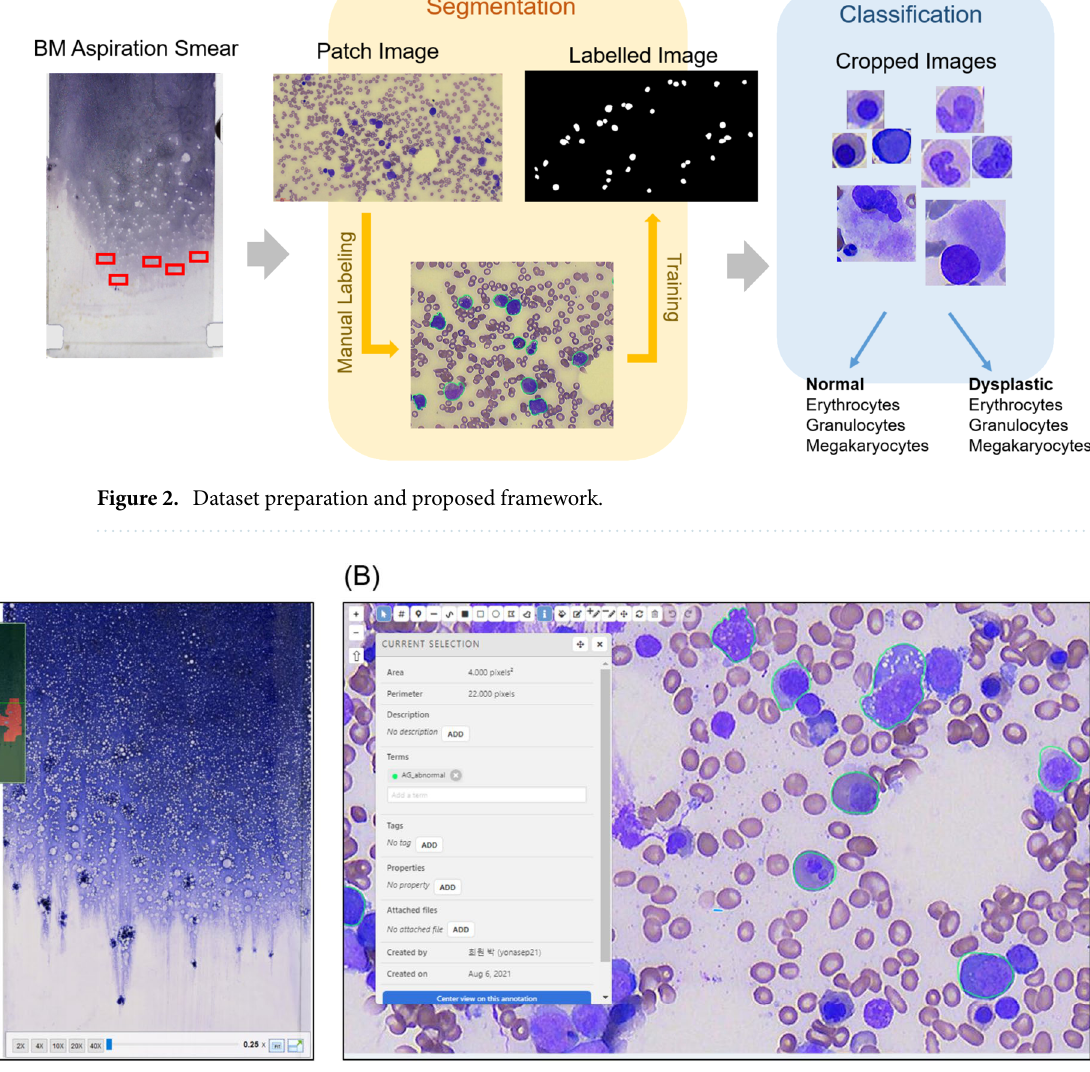
Figure 3. Manual labeling process of nucleated cells. ( A ) Whole slide scanning of bone marrow aspiration slide ( B ) Web-based interface for assisted annotation that enables manual labeling of nucleated